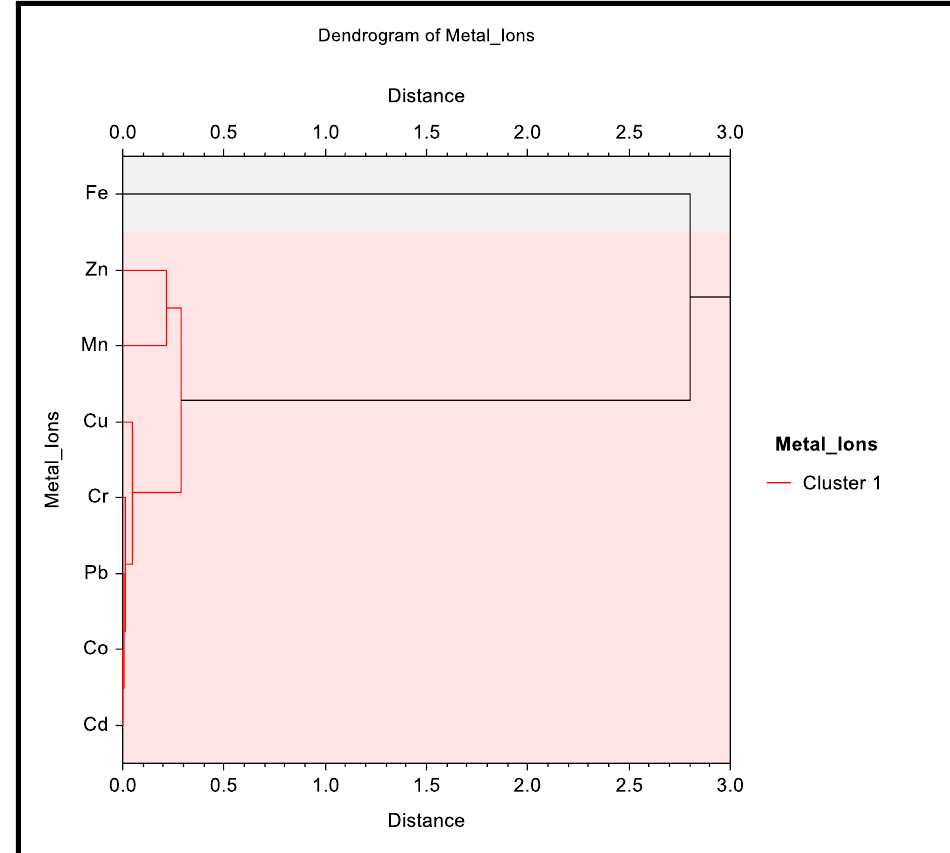
Figure 5. Dendrogram tree obtained after HCA analysis of heavy metals as variables. Only one major cluster was observed showing similar characteristics of the seven tested metals.